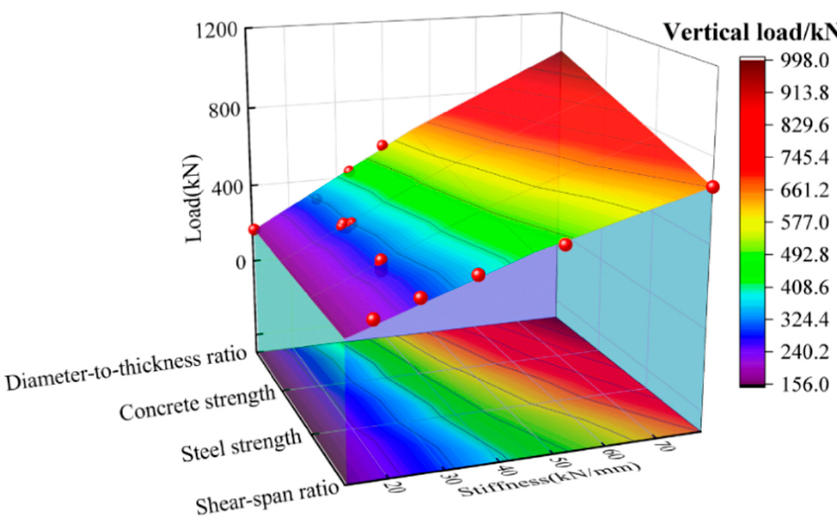
Figure 14. Influences on bearing capacity and stiffness.